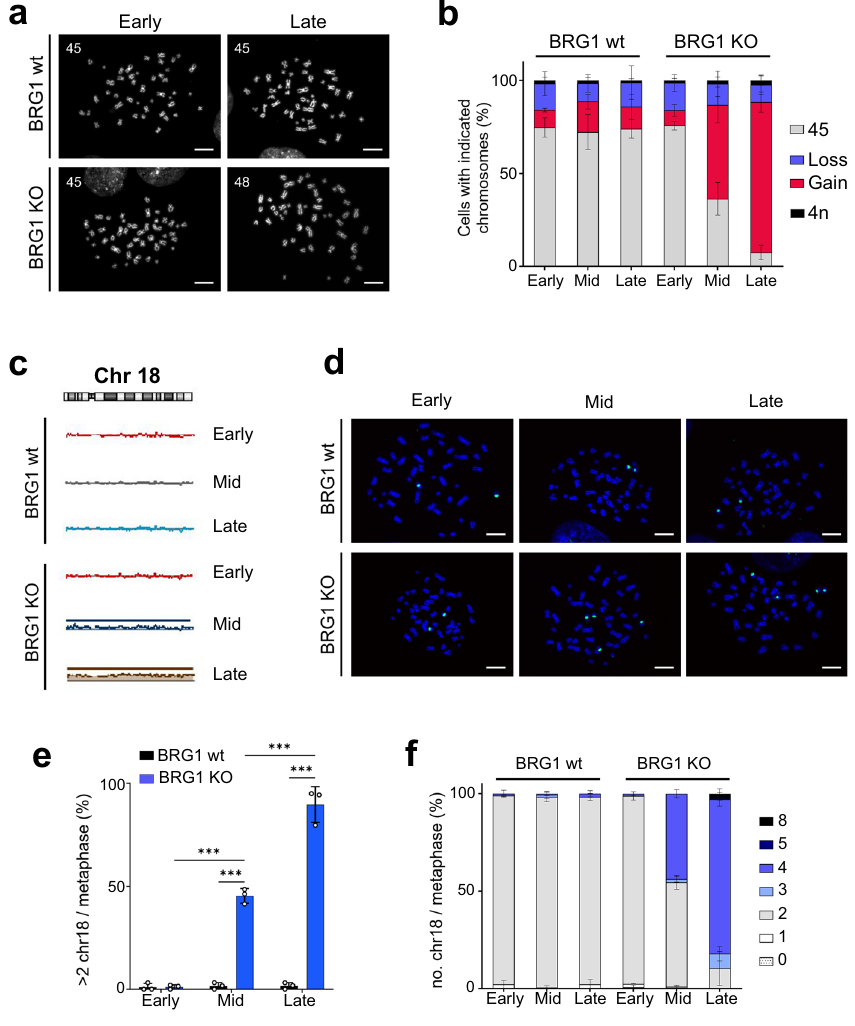
Fig. 3 The improved fi tness of BRG1-de fi cient cells over time correlates with the gain of additional copies of chromosome 18. a Representative metaphase spreads prepared from HCT116 and BRG1 knockout (KO) cells (clone 2) at early and late (8 months) time points. The number of chromosomes in each metaphase are indicated. Scale bar = 10 µ m. b The BRG1 KO cell population (clone 2), but not the HCT116, gains chromosomes during long-term cell culture. The number of chromosomes per metaphase was quanti fi ed, and the percentage of cells with gain or loss was calculated. At least 50 metaphases were analysed for each sample. Data were presented as the mean ± SD; n = 3. c BRG1 knockout cells (clone 2) acquire additional copies